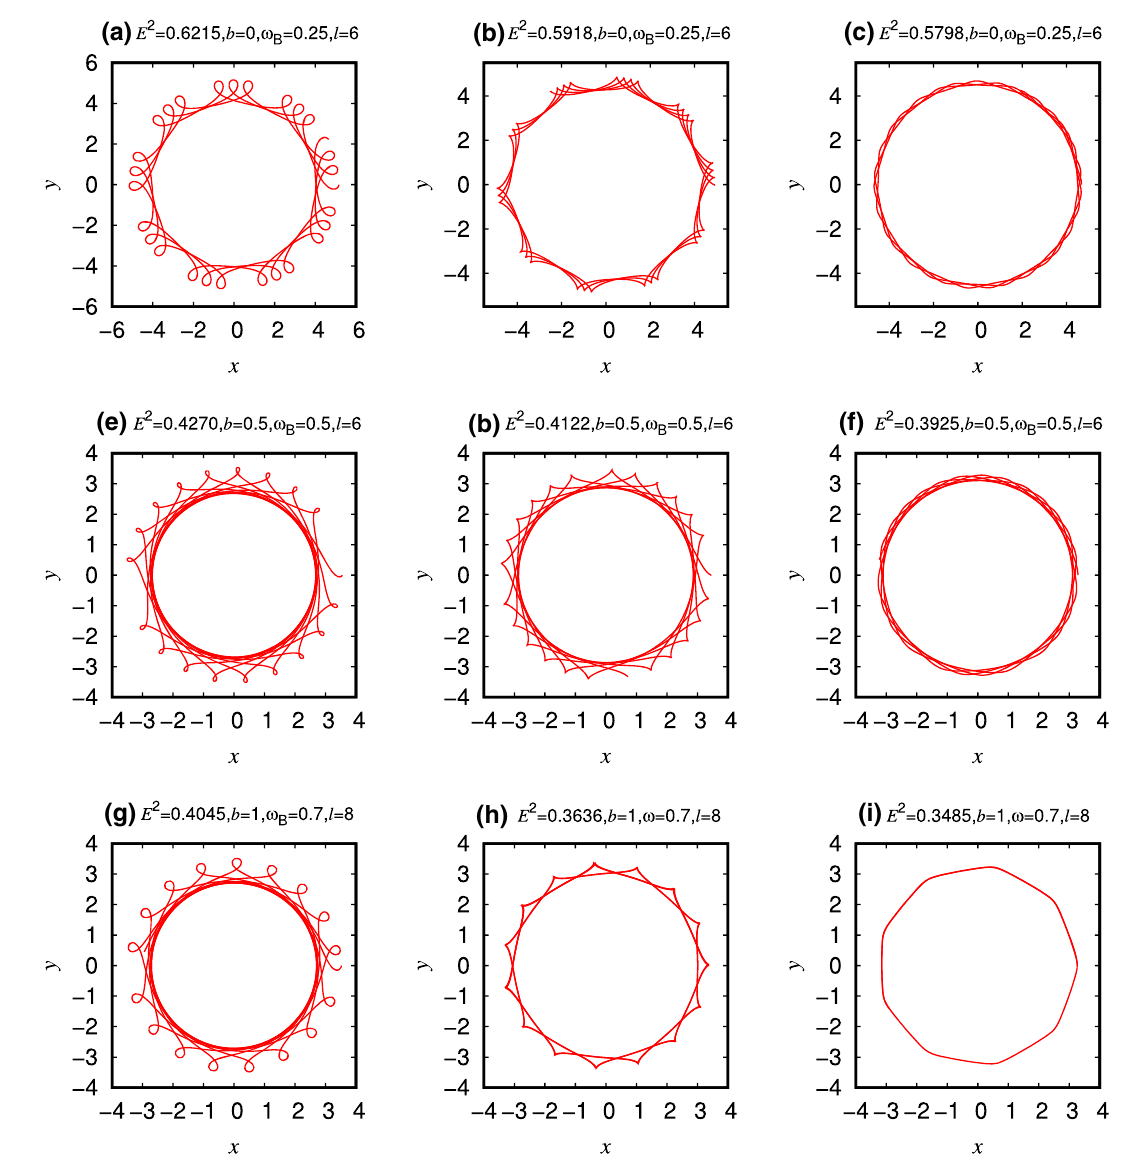
Fig. 11 Three types for charged test particles’ bounded trajectories around quantum-corrected Schwarzschild black holes immersed in an external asymptotically uniform magnetic field with l > 0 (the Lorentz force is repulsive). The first column has curls with the con-